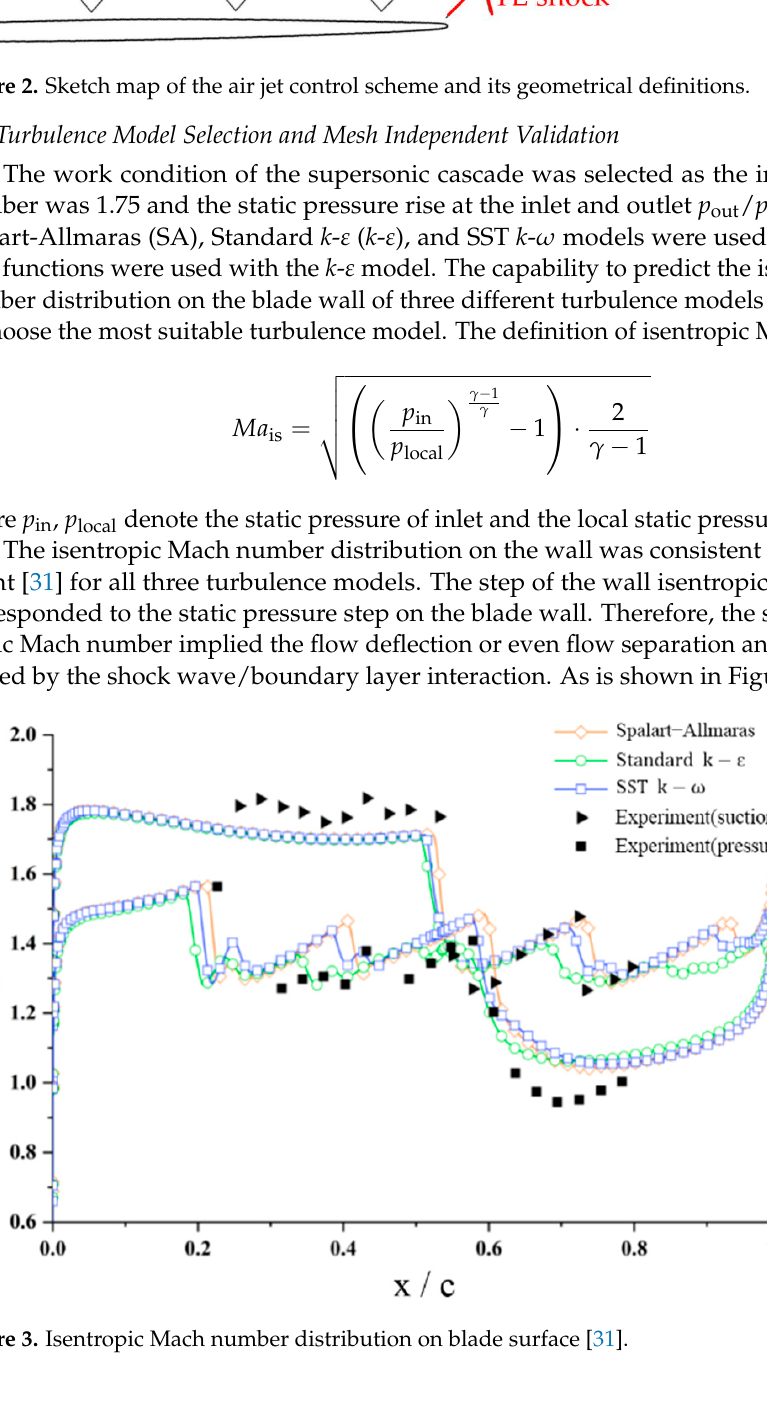
Figure 2. Sketch map of the air jet control scheme and its geometrical definitions.